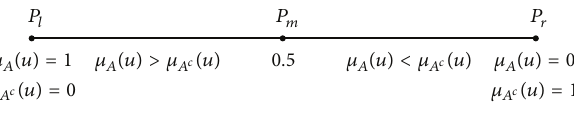
Figure 7: Opposite fuzzy set